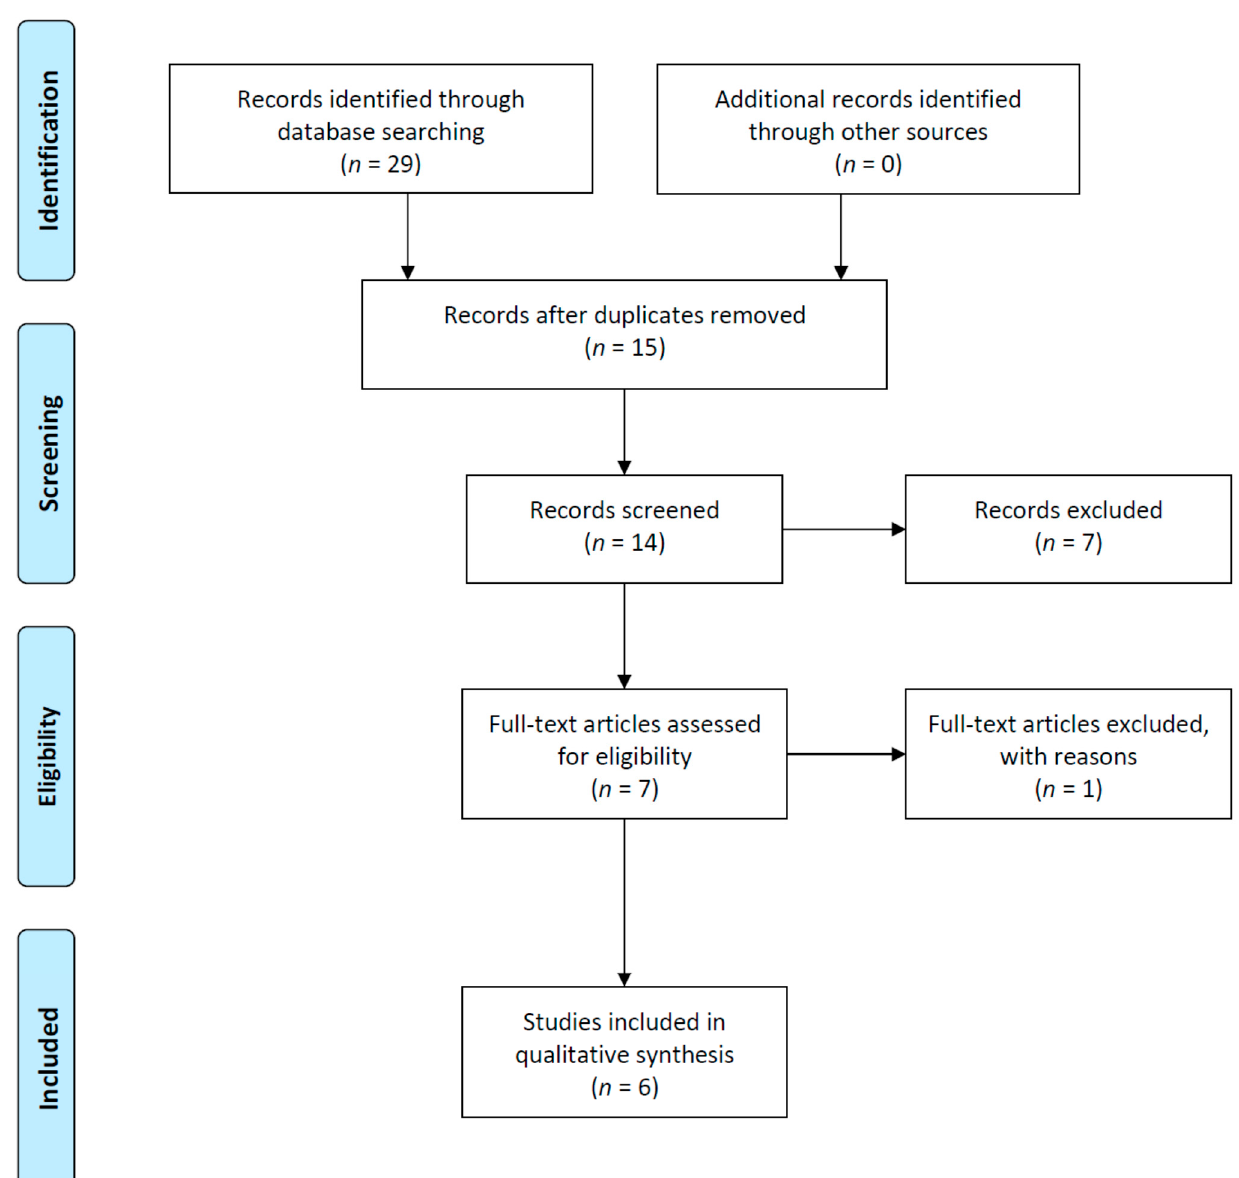
Figure 1. PRISMA flow diagram.